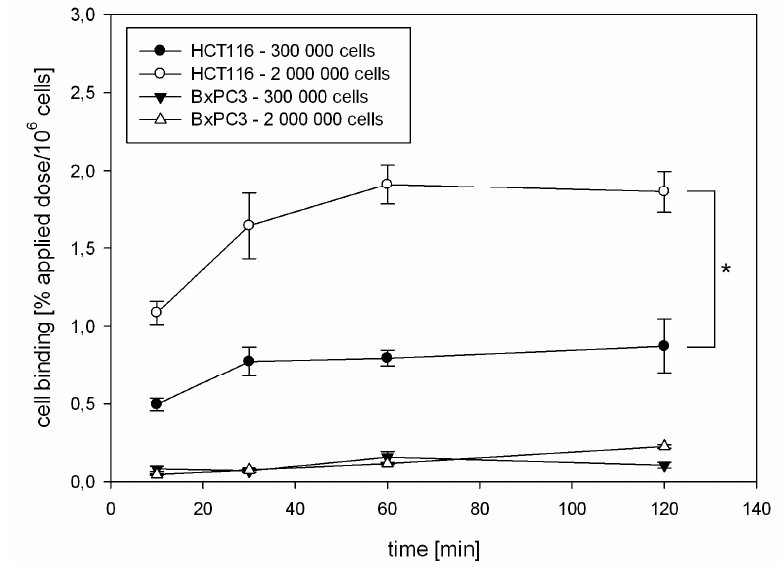
Figure 4. In vitro kinetics of 125 I-CaIX-P1 on HCT116 and BxPC3 cells at two different cell densities. Mean values and standard